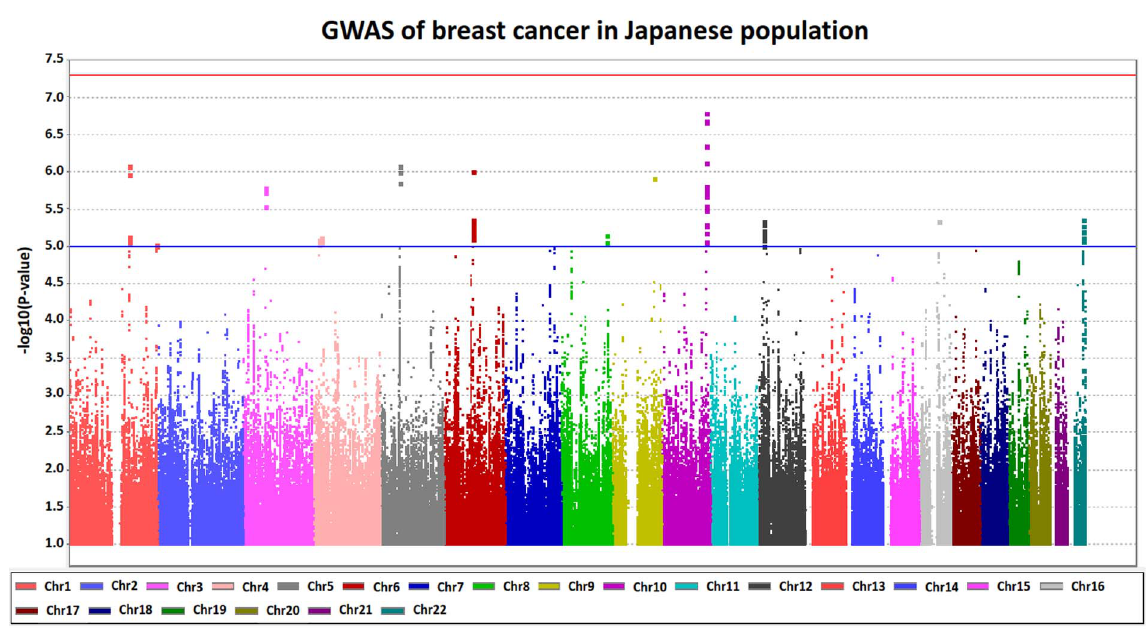
Figure 1. The Manhattan plot for GWAS of breast cancer in the Japanese population. This plot is based on –log 10 ( P -value) from GWAS and imputation analysis against chromosome position, each color represents different chromosome. Blue line indicate suggestive association threshold, P =1 6 10 2 5 while red line indicate genome-wide significant threshold P , 5 6 10 2 8 .